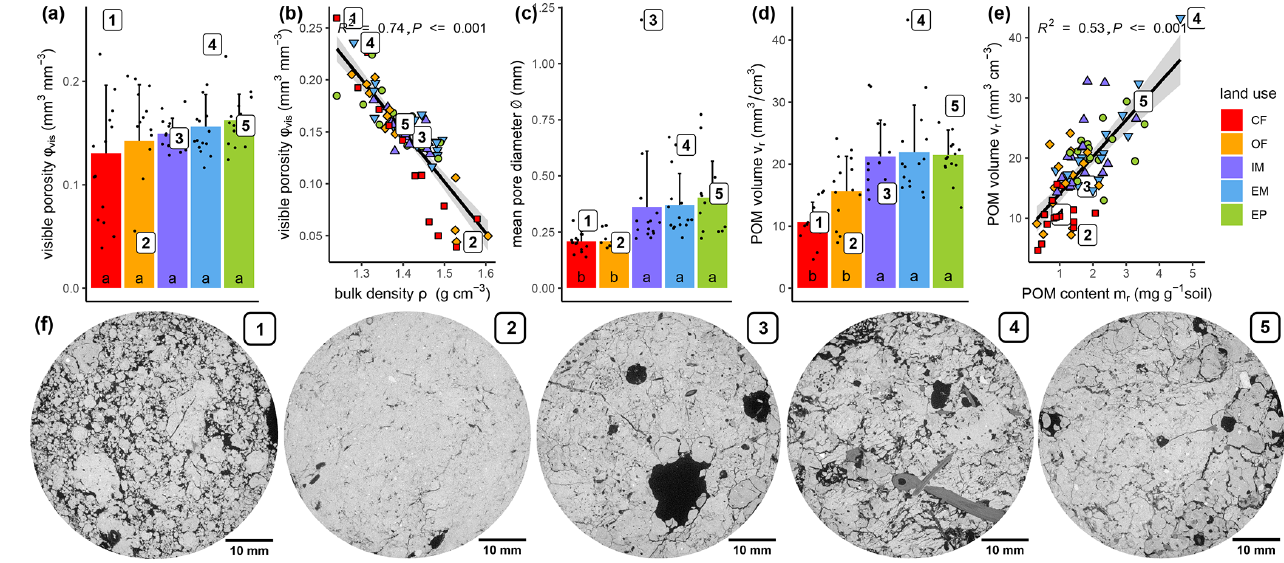
Figure 3. Selected microstructure properties (a, c, d) and relation to selected bulk properties (b, e) for different land uses. Columns and error bars represent mean and standard deviation at the plot level ( n = 5), whereas dots represent individual soil cores. Numbered dots in subfigures (a) – (e) correspond to the five selected X-ray CT samples, for which 2D sections are shown below. Different letters in bar plots (a, c, d) indicate significant differences ( p< 0 . 05) between land use